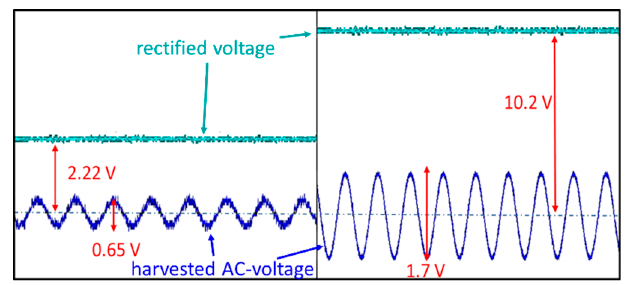
Figure 10. Harvested power comparison of two systems: ( a ) typical radio frequency energy harvesting system and ( b ) proposed radio frequency energy harvesting using a relay resonator system.